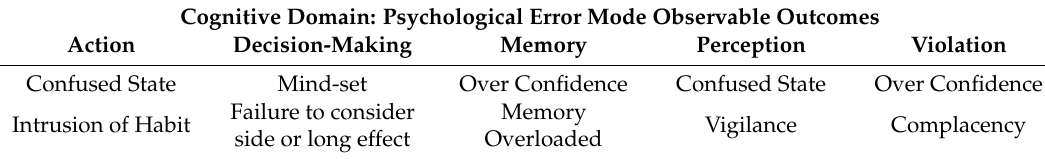
Table 7. Psychological Error Mode taxonomy.